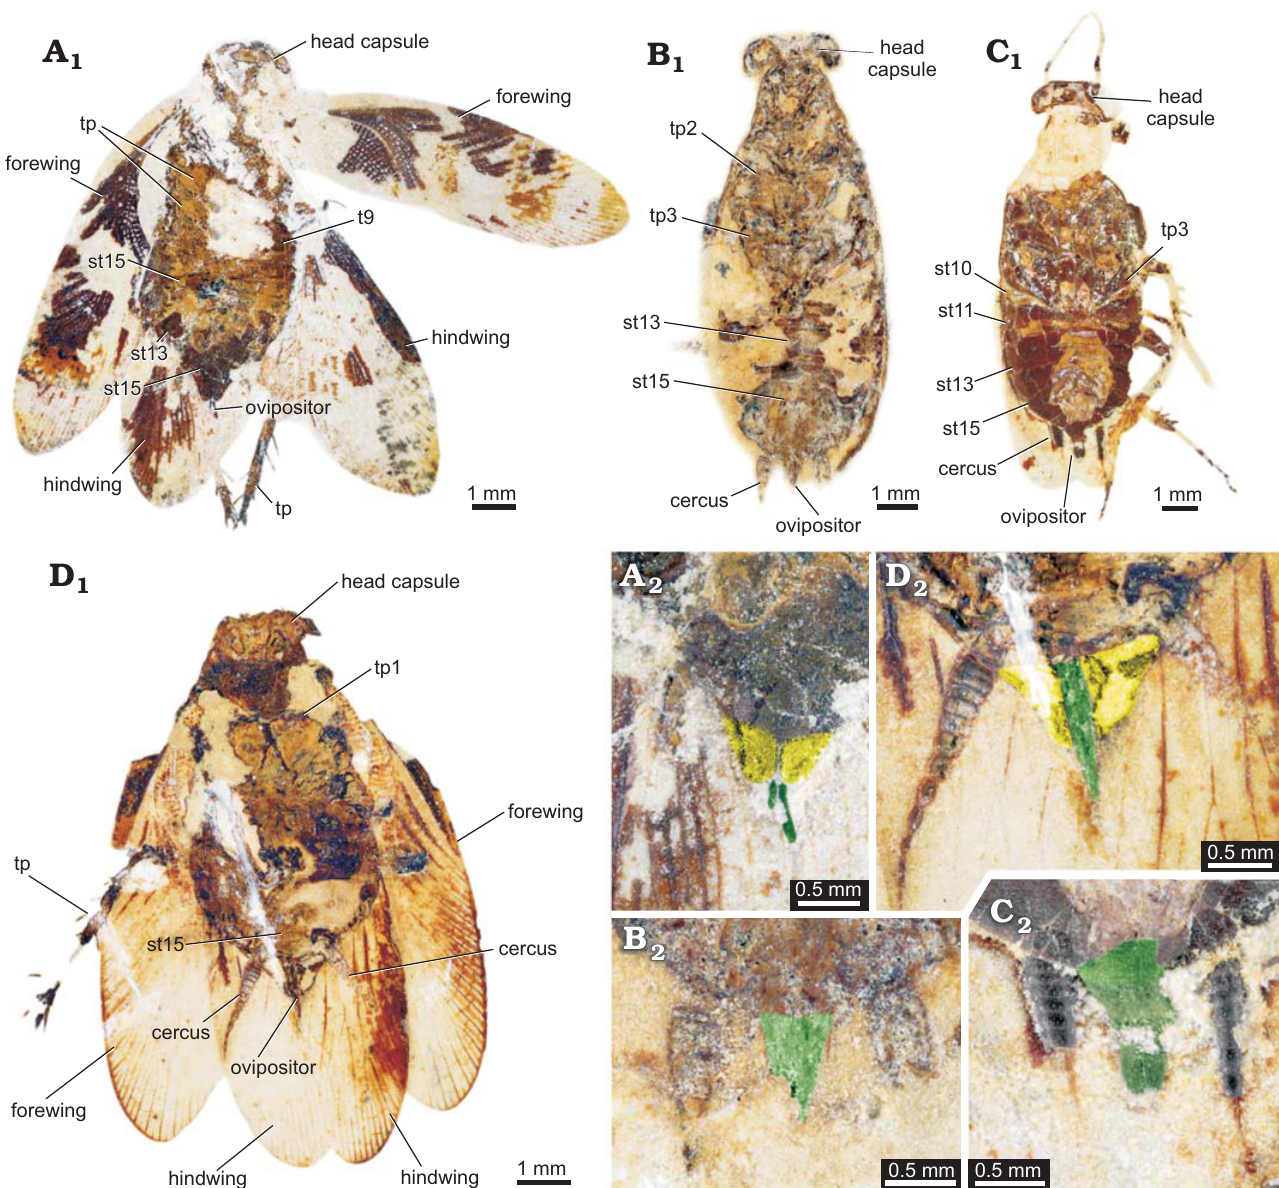
Fig. 13. Ponopterix maxima Bechly, 2007 (B, C) and undescribed roachoids (A, D) from the Aptian, Cretaceous Crato Formation of Brazil; in ventral views with interpretations of preserved structures. A . ROMIP64637. B . ROMIP64639. C . ROMIP64640. D . ROMIP64641. A 1 –D 1 , overviews; A 2 –D 2 , colour-marked close ups of the ovipositor (green, valves 1; yellow, part of post-ocular segment 15 [sternite 7; subgenital plate]). Abbreviations: st10–15, sternite of post-ocular segment 10–15 (abdominal segment 2–7); t9, tergite of post-ocular segment 9 (abdominal segment 1); tp1–3, thoracopod 1–3